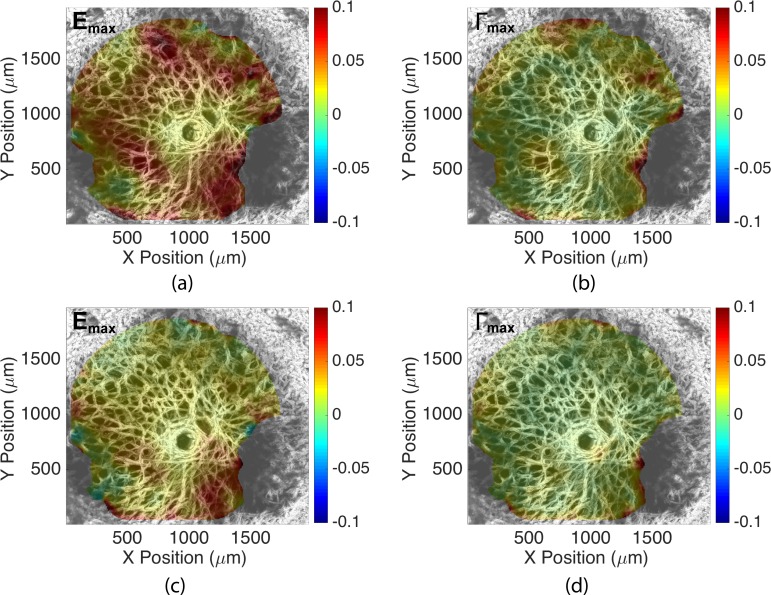
The change in the strain response of specimen 1 from 5 to 45 mm Hg after sGAG degradation: (a) Emax after buffer treatment, (b) Γmax after buffer treatment, (c) Emax after enzyme treatment, and (d) Γmax after enzyme treatment. Both strain measures decreased after enzyme treatment.